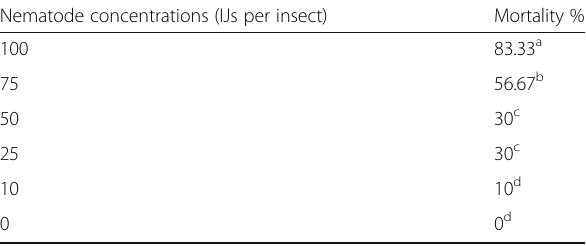
Table 4 Mean comparison of Agrotis segetum mortality in different concentrations of Steinernema carpocapsae